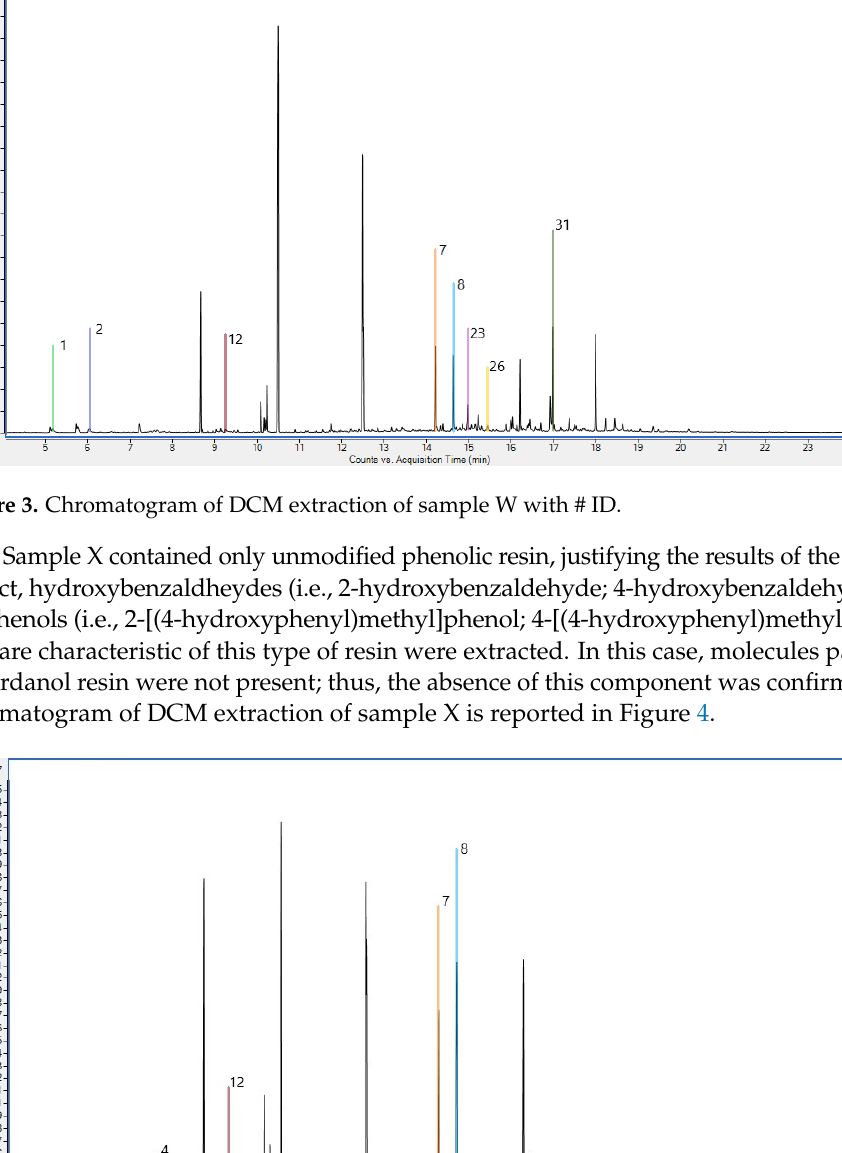
Figure 5 . Chromatogram of DCM extraction of sample Y with # ID. In sample Z, different molecules characteristic of phenolic resin, such as bisphenols (i.e., 2-[(4-hydroxyphenyl)methyl]phenol; 4-[(4-hydroxyphenyl)methyl]phenol), were found. In addition, there were many compounds that were not identified by the library, but whose mass spectra were attributable to silanes or siloxanes. Since these peaks were not present in other samples and since the only change made between the different pads was in the resin, it can be deduced that these signals derive from the resin used, thus distinguishing the one silicone modified from the other one. The chromatogram of DCM extraction of sample Z is reported in Figure 6.